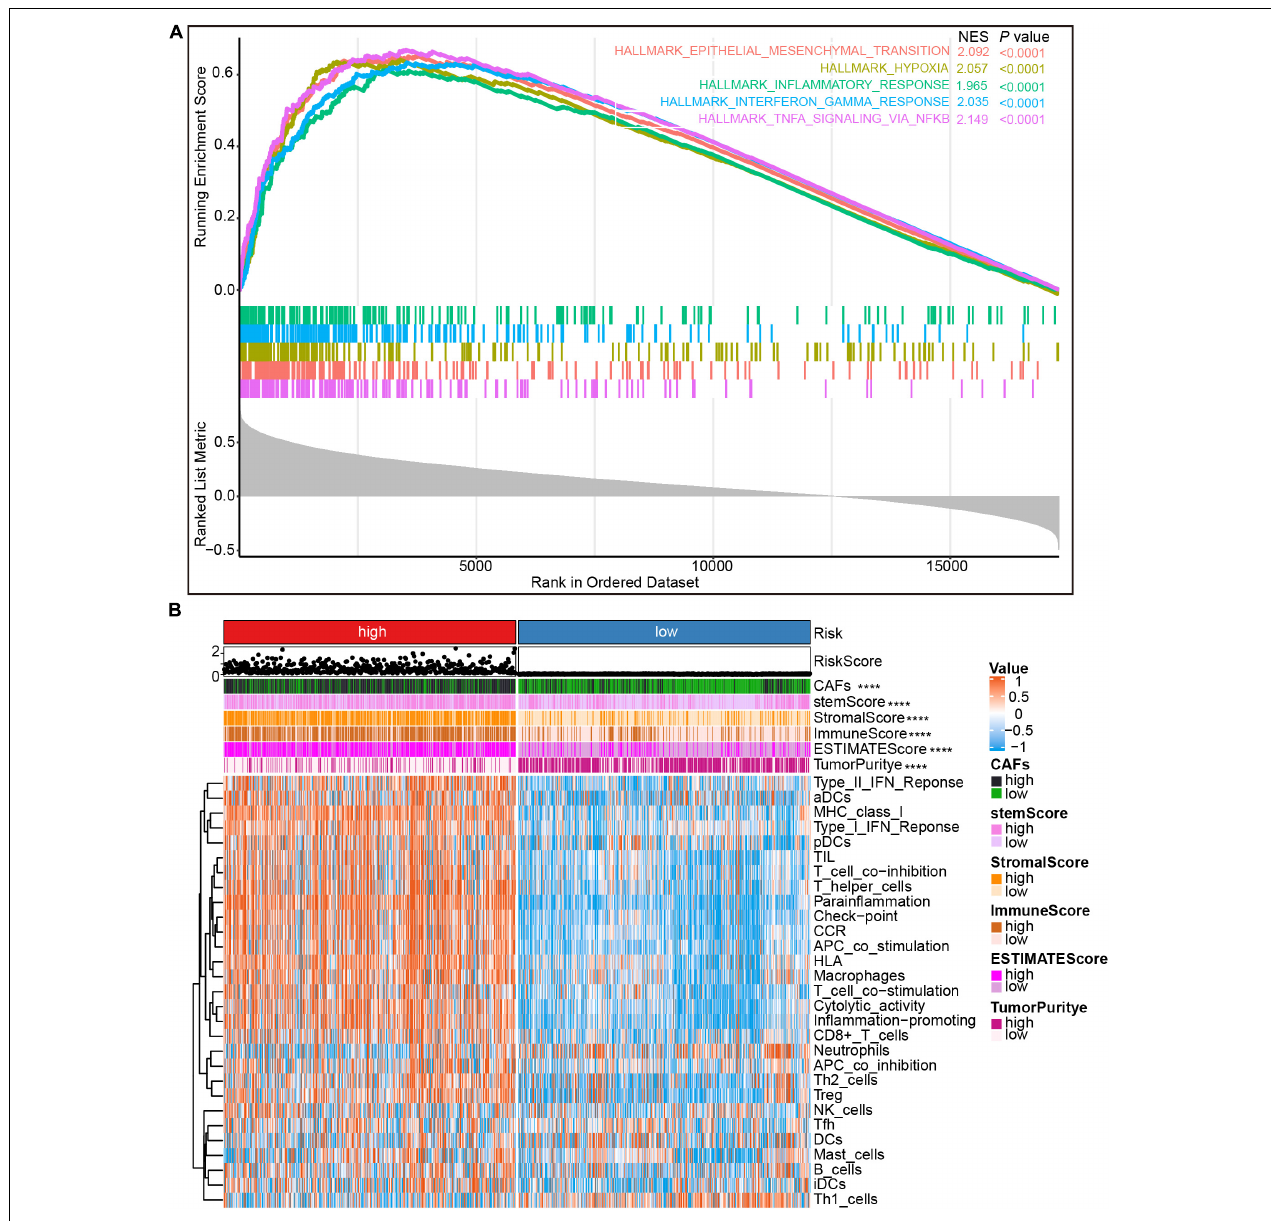
FIGURE 6 | Gene set enrichment analysis (GSEA) and immune cell infiltration analysis. (A) The GSEA of genes positively correlated with risk score. (B) Heatmap showing immune cells infiltration by ssGSEA algorithm between low- and high-risk groups in the CGGA cohort. NES, normalized enrichment score. **** P < 0.0001.